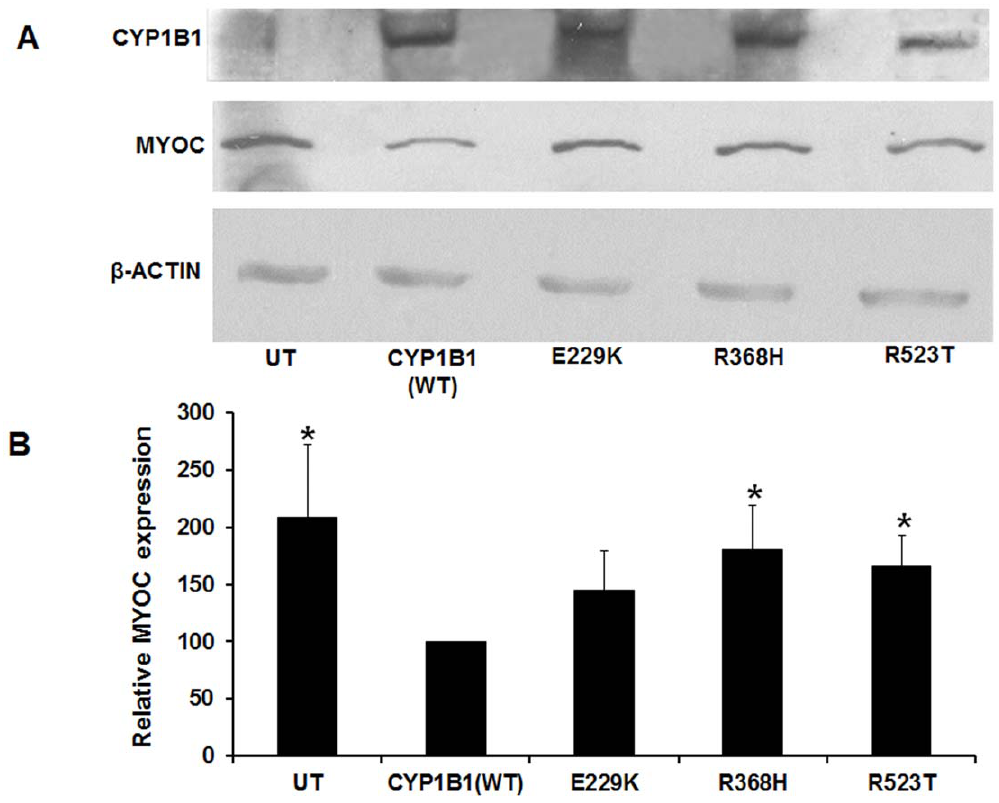
Figure 8. CYP1B1 mutants cause upregulation of MYOC in HTM cells. A : Increased MYOC expression with mutant CYP1B1 . Western blot analysis of mutant CYP1B1 and myocilin showed increased expression of MYOC in the presence of mutant CYP1B1 clones with reduced ( , 10%) 17 b estradiol metabolizing activity. B : Quantitative analysis of MYOC expression . The histogram shows levels of expression of endogenous MYOC in HTM cells transfected with wild type and mutant CYP1B1 clones. All the three mutants of CYP1B1 (i.e. E229K, R368H and R523T) considerably over- expressed MYOC compared to the normal CYP1B1. The R368H and R523T showed statistically significant over expression of myocilin with a p-value of 0.023 and 0.014, respectively. However, the effect of E229K mutant was not found to be statistically significant. This experiment was repeated three times [*p-value- , 0.05].